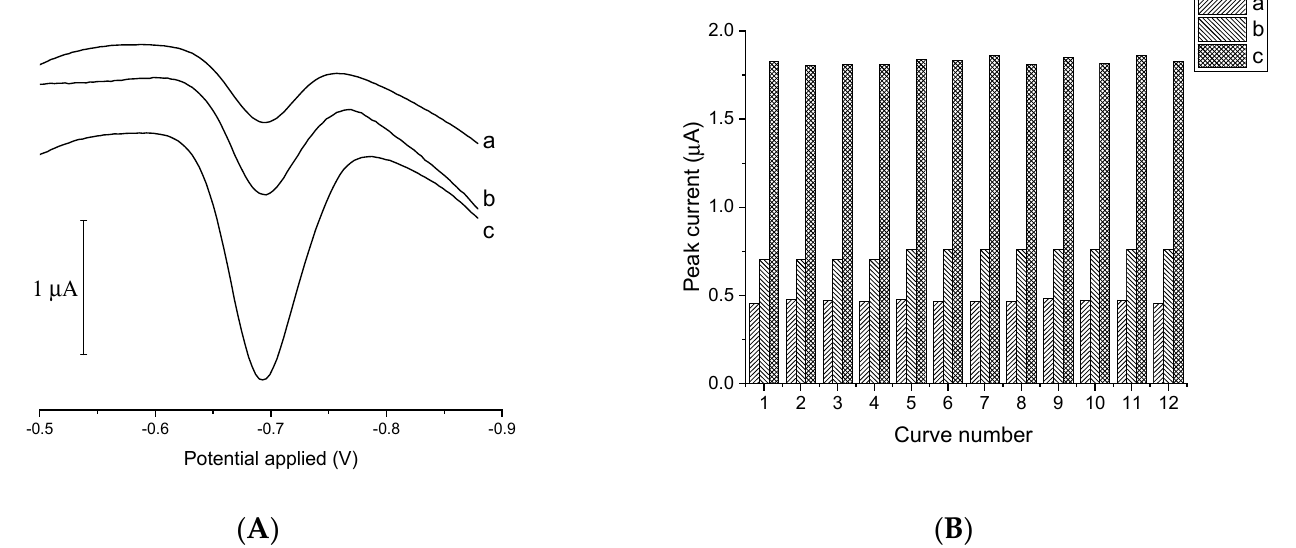
Figure 1. ( A ) Voltammograms recorded in a solution containing 25 nM of Ge(IV) using bismuth films plated on Au (a), Pt (b), and GC (c) disc electrodes. ( B ) Ge(IV) peak currents determined from twelve successive voltametric measurements involving Au (a), Pt (b), and GC (c) disc electrodes plated with Bi film. Composition of the supporting electrolyte: 0.05 M acetate buffer, 1 mM of catechol, 1 mM of V(IV), and 1.5 mM of HEDTA. Instrumental parameters: accumulation time 30 s, accumulation potential − 0.4 V. Electrode preparation: electrodeposition at − 0.9 V in a 0.04 M Bi(III) solution, carried out for a period sufficient to transfer a charge of 7.07 mC per mm 2 of the surface area of the support